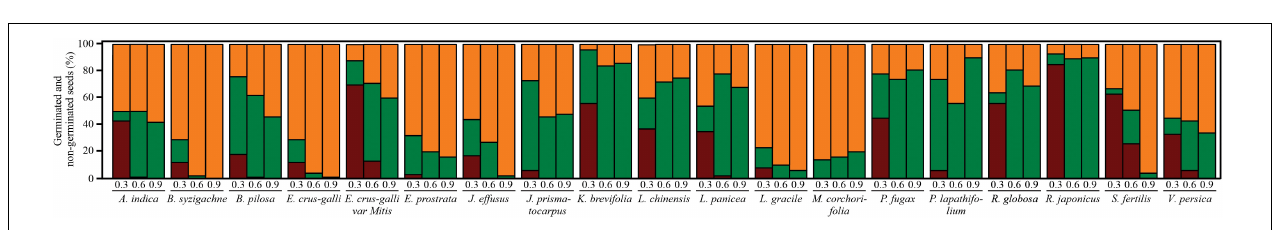
and dark treatments ( r = − 0.372; P = 4.02 × 10 − 5 ),